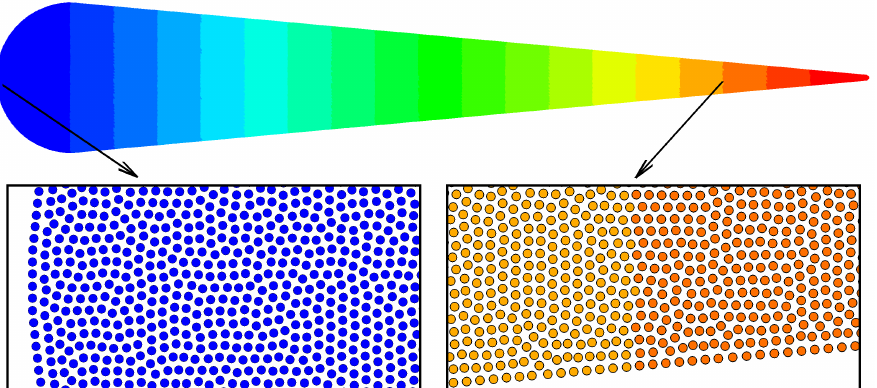
Figure 7. The body-fitted and uniformly distributed 2D particles generated by the CAD-BPG solver: an example of a 2D hydrofoil. The color represents the x -axis